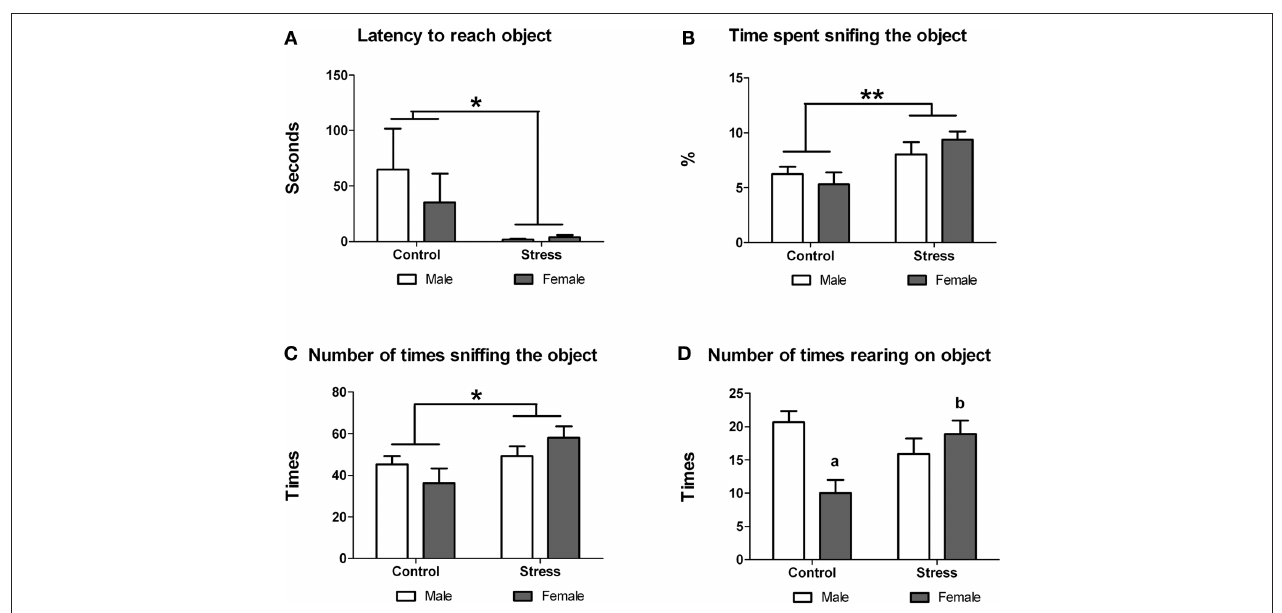
Figure 3 | effect of peri-pubertal stress on behavior at the novel object test. Mean (SEM) behavioral measures of reactivity to novelty (novel object test) for male and female rats that underwent either peri-pubertal stress (Stress) or no stress (Control). (a) Latency to reach object, (B) time spent sniffing the object, (c) number of times sniffing the object, and (D) number of times rearing on the object. * p < 0.05 treatment effect; ** p < 0.01 treatment effect; a p < 0.01 post hoc comparison between control male and females; b p < 0.01 post hoc comparison between stressed and control